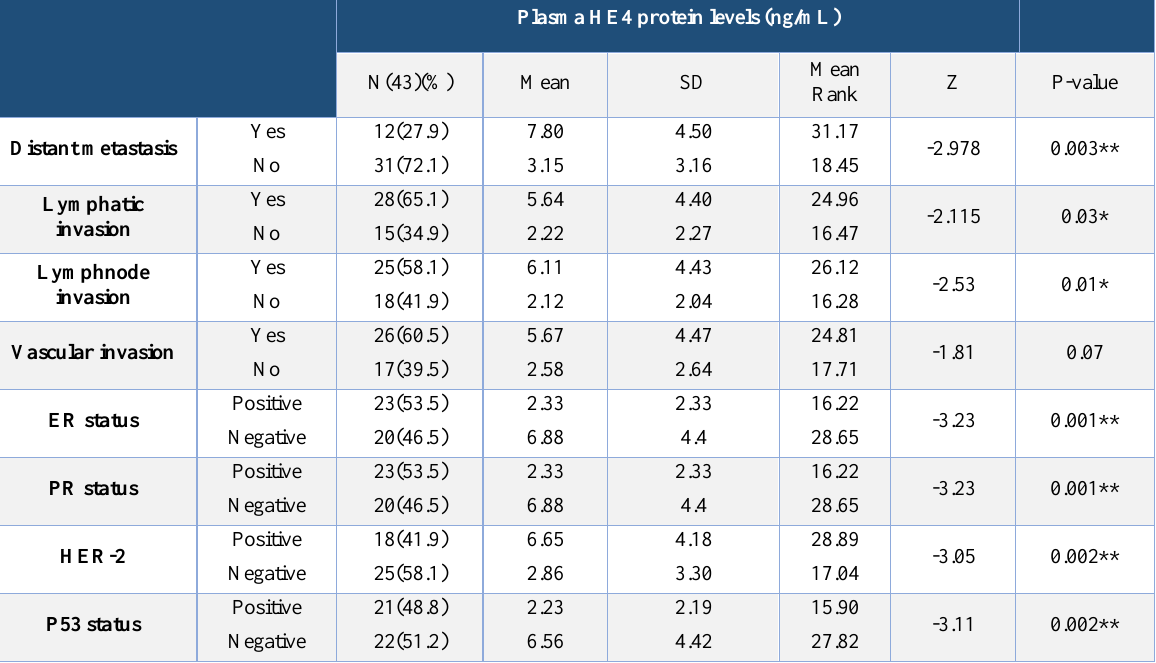
Table 6. Association between plasma HE4 expression in BC patients and occurrence of metastases, HR status, HER2 expression, and P53 mutation status. Results of non-parametric Mann-Whitney U